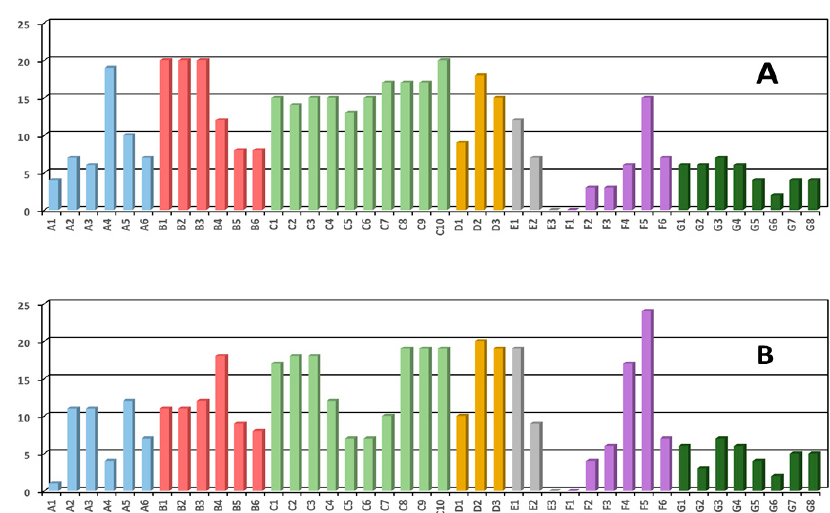
Figure 12. Number of areas (boxes) connected in export ( A ) or import ( B ) through anticyclonic eddies across the 1° × 1° cells over the WMED.